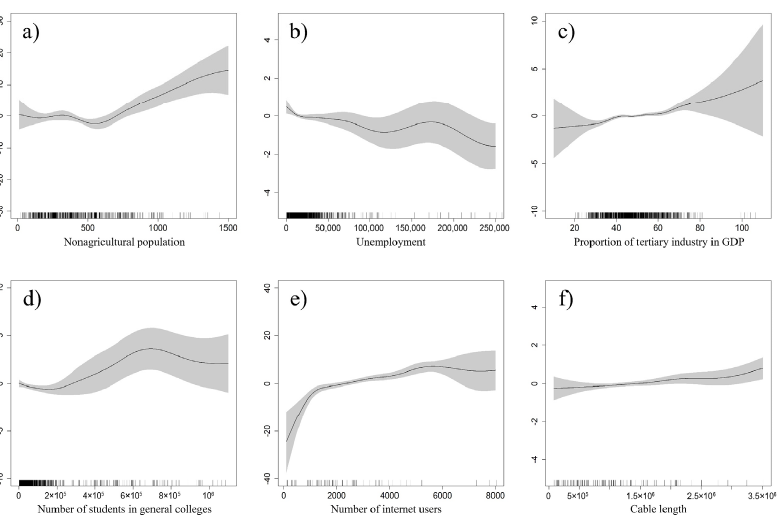
Figure 3. ( a – f ) Relationships between cyber fraud cases and environmental factors. The x-axis represents the distribution of data points for each variable. The y-axis represents the partial effect of each variable. The grey shaded areas indicate the 95% confidence intervals.